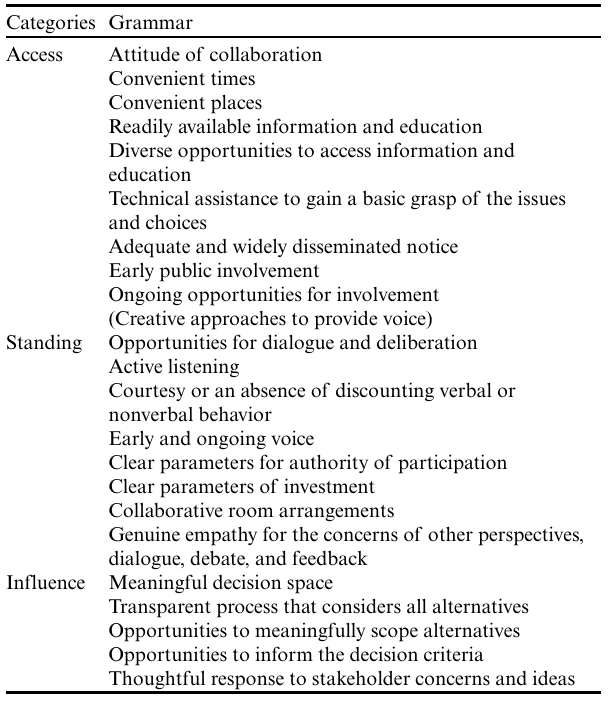
Table 1 . The Trinity of Voice (Senecah